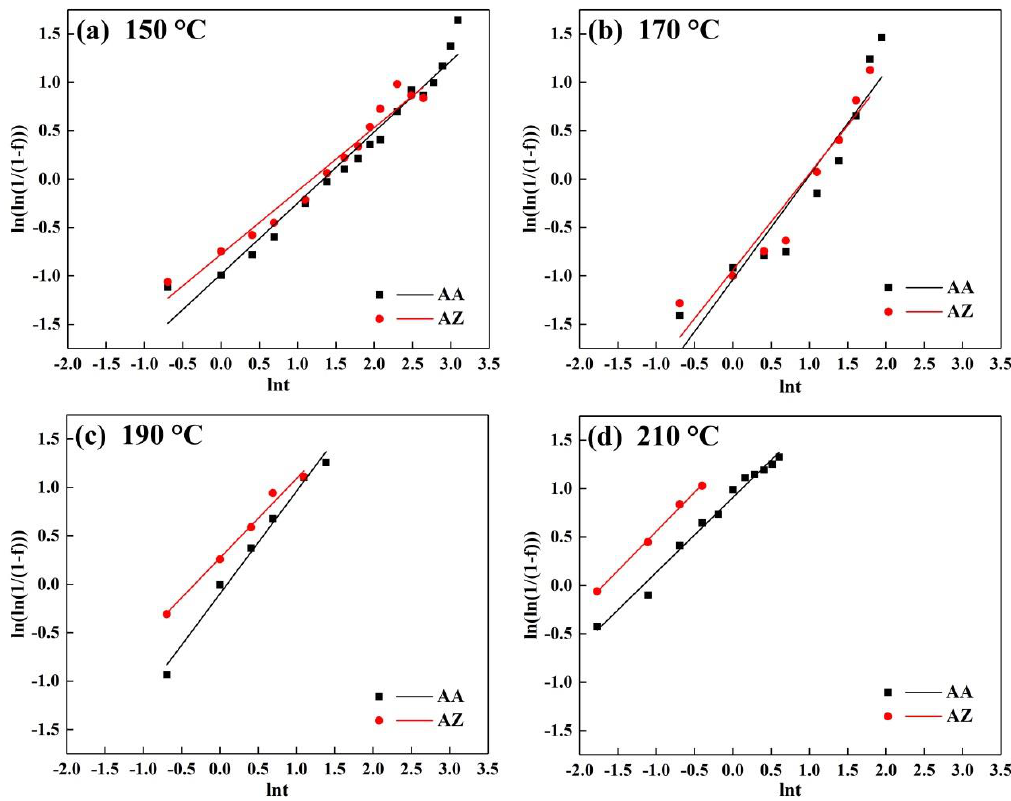
Figure 12. Johnson–Mehl–Avrami (JMA) plots of alloy AA and AZ at di ff erent aging temperatures: Figure 12. Johnson – Mehl – Avrami (JMA) plots of alloy AA and AZ at different aging temperatures: ( a ) 150 ◦ C, ( b ) 170 ◦ C, ( c ) 190 ◦ C, and ( d ) 210 ◦ Table 8. Values of n and K for alloy AA and AZ at different aging temperatures T (°C)